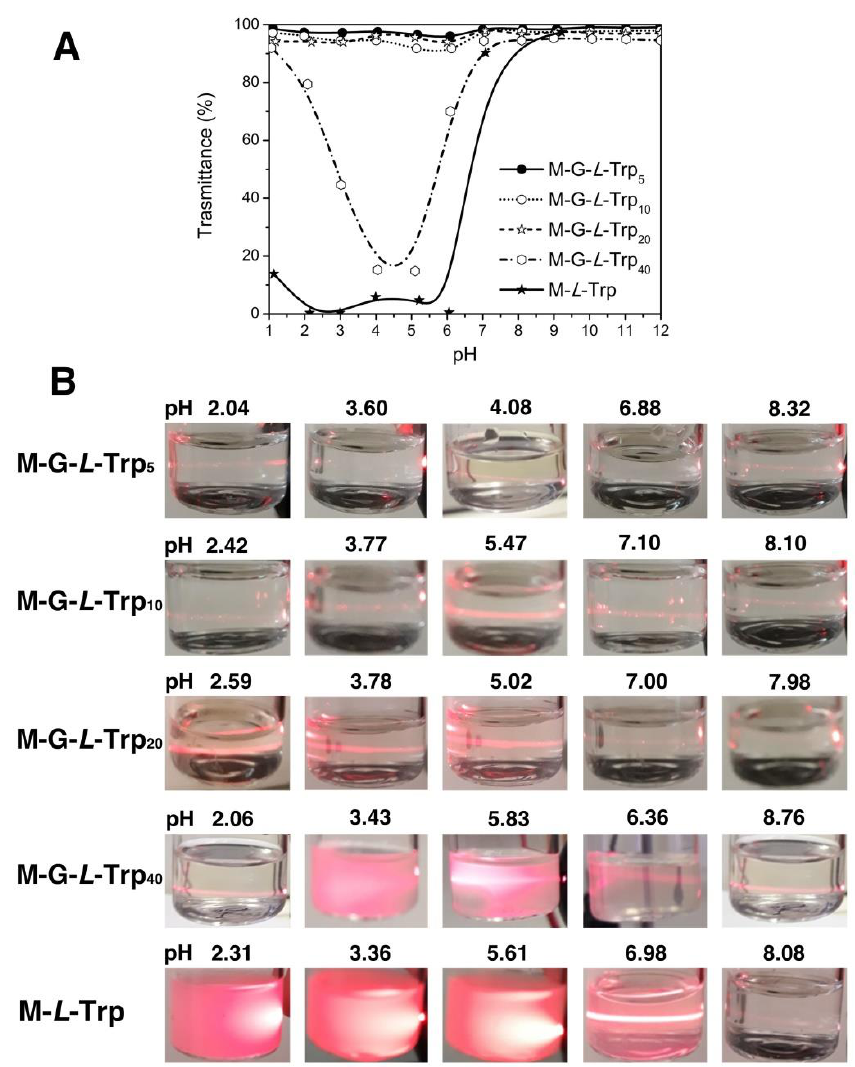
Figure 3. Solubility of M-G- L -Trp copolymers in water. ( A ) pH-dependence of transmittance at 480 nm; ( B ) scattering of a polarized IR beam. Measurements were performed on 1 mg·mL − 1 solutions at 25 °C.